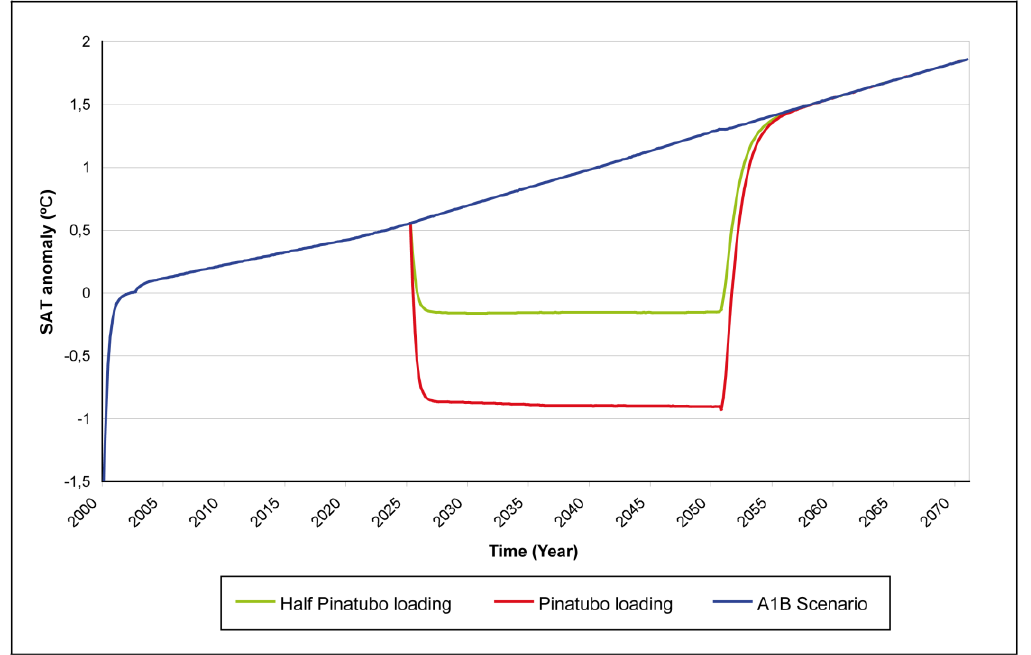
Figure 6. SAT response to a geoengineering failure at 2050 with different aerosol